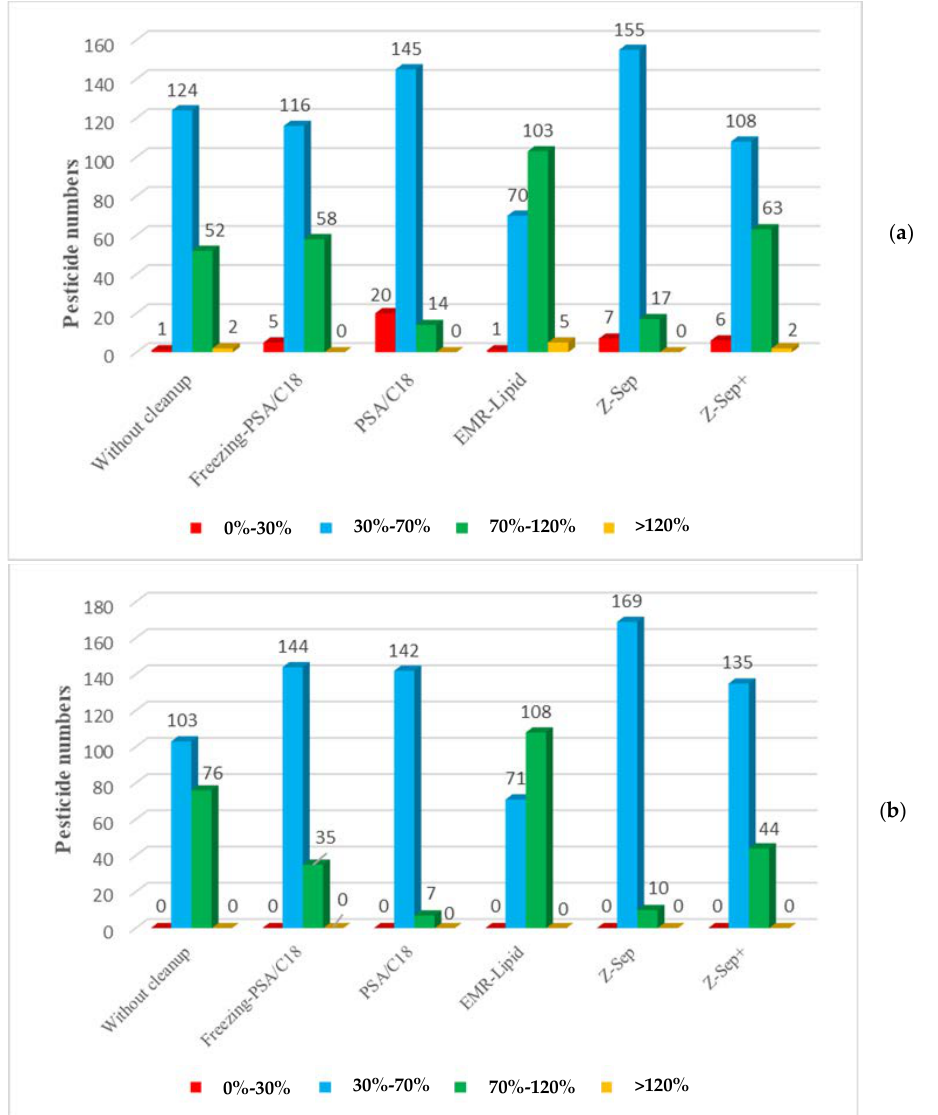
Figure 2. Pesticide recoveries in rapeseed extracts purified with different d-SPE sorbents at two spiking levels: 10 µg/kg ( a ) and 50 µg/kg ( b ).